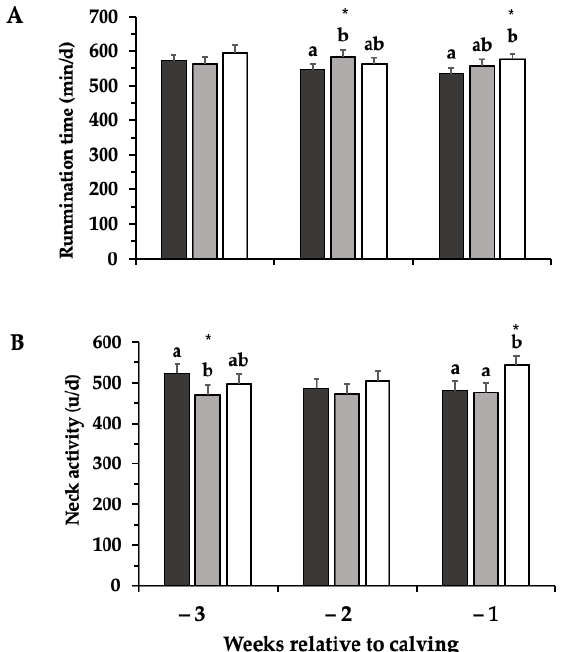
Figure 3 . Rumination time ( A ) and neck activity ( B ) of dairy cows kept in an outdoor paddock from 3 weeks before calving until calving day (black bar), or subjected to an early (3 weeks before calving; gray bar) or late movement (1 week before calving; white bar) to an indoor maternity pen were they remained until calving day ( n : 13 cows per treatment). Least squares means and SE are reported. Different letters (a, b) indicate a statistical difference in the same week. * p < 0.05.